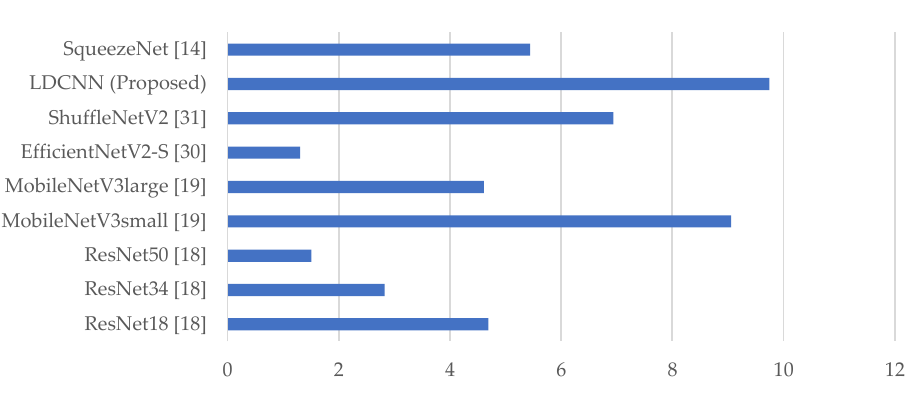
Figure 16. Comparisons with other related models. Table 5. Comparison of using a public dataset.